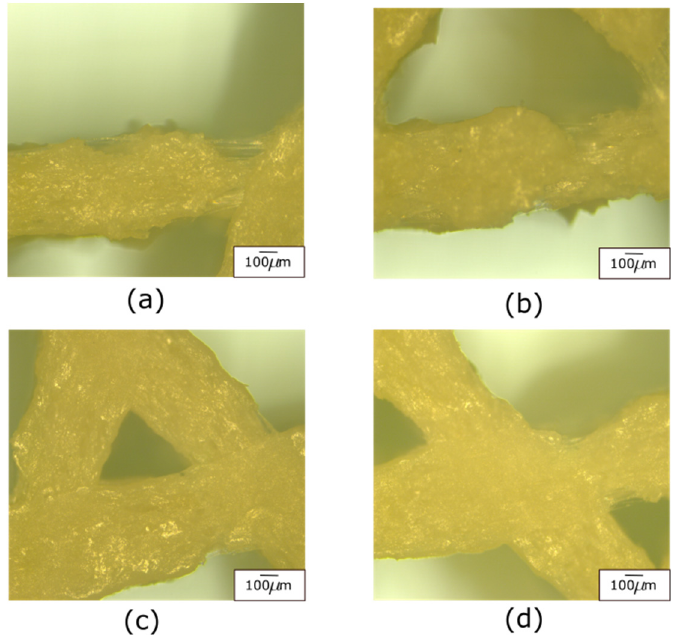
Figure 8. Micro-characterization of PLA-wood lattices. Representative optical micrographs with 50× magnification and 100 µm of measurement scale exhibiting defects in star topology ( a , b ) 40% and ( c , d ) 20% infill density. All micrographs correspond to the bottom side of the samples.